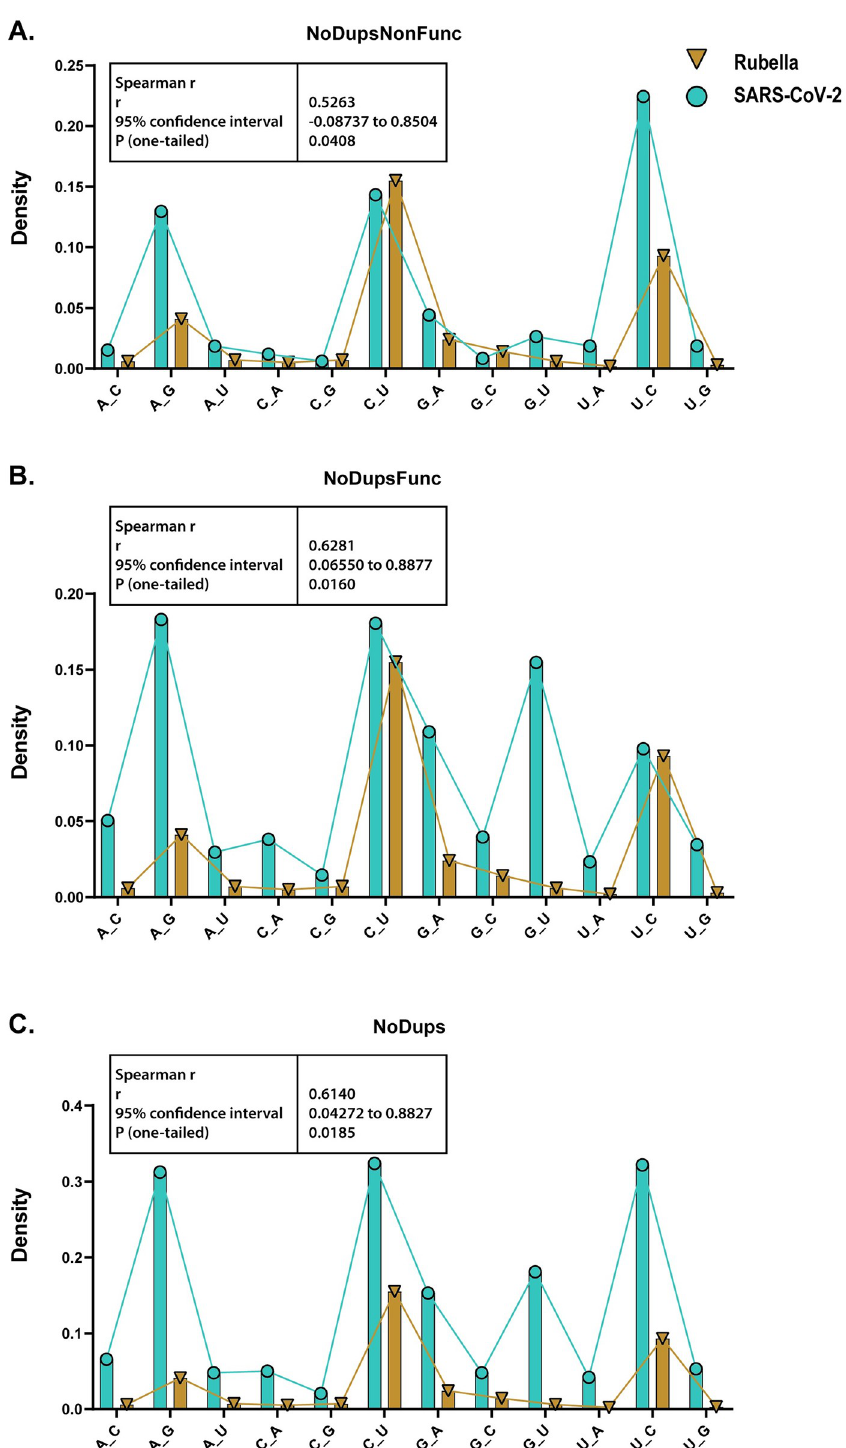
Fig 2. Comparison of base substitution spectra between rubella virus and SARS-CoV-2 datasets from filtered MAFs. Creation of filtered SARS-CoV-2 MAFs and their abbreviated names NoDupsNonFunc, NoDupsFunc, NoDups, are described in Fig 1 and in associated text. The spectrum from each SARS-CoV-2 filtered MAF was compared with rubella mutation spectrum. Bars represent densities of base substitutions in each dataset calculated by dividing counts of each base substitution by counts of the substituted base in the reference sequence. Connecting lines